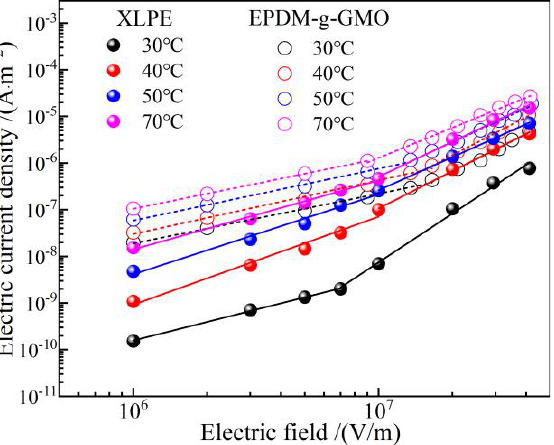
Figure 11. Electric conduction J-E characteristics of XLPE compared with EPDM-g-GMO.